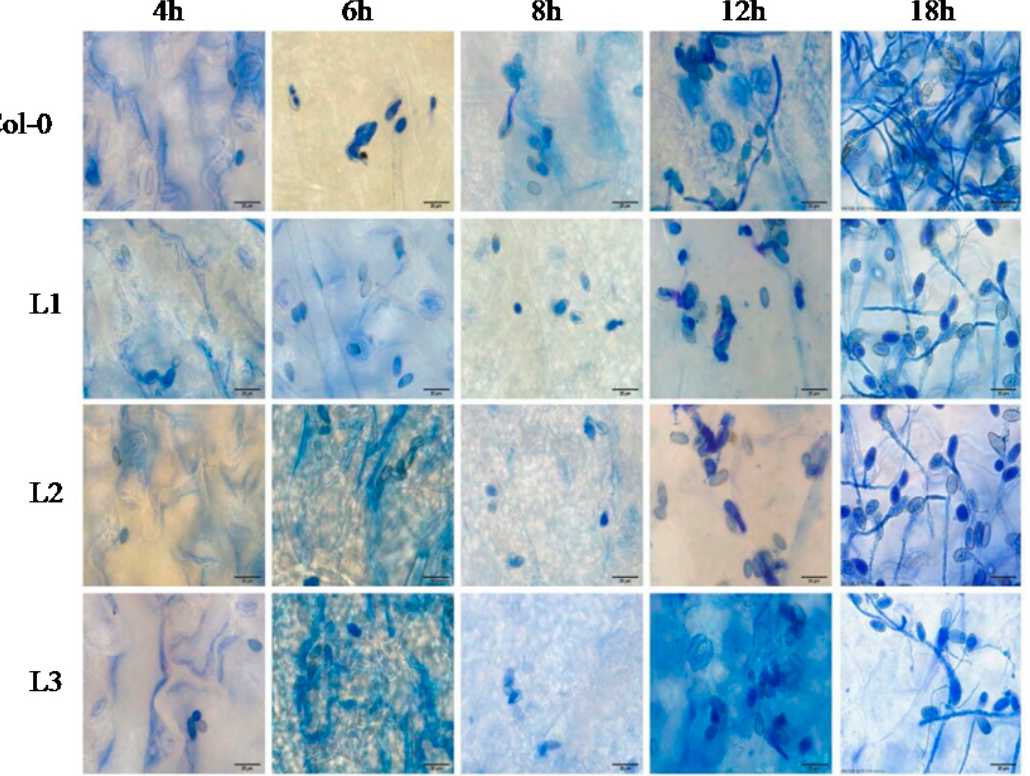
Figure 6. Comparison of Botrytis cinerea conidia development on transgenic A. thaliana and Col-0 leaves. Leaves were harvested at 4, 6, 8, 12, 18 h post inoculation (hpi) to detect progression of B. cinerea colonization and examined using a light microscope. The scale bar in the figure indicates 20 µm. Experiments were repeated three times.